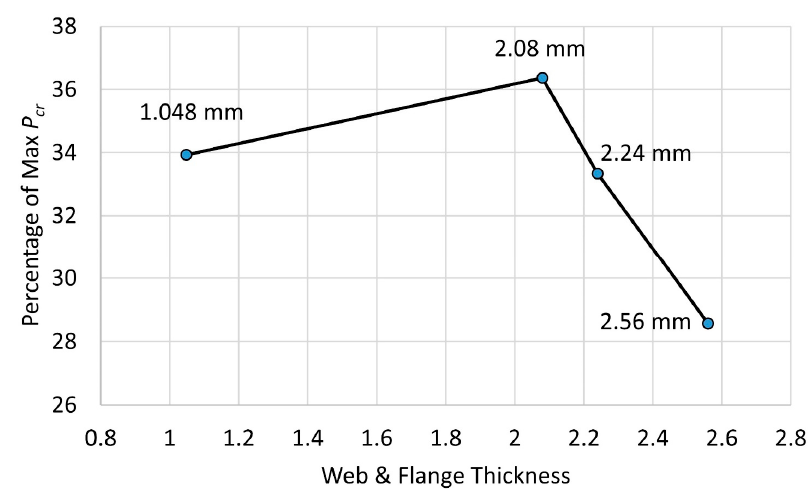
Figure 13. Cost e ffi ciency of column thickness on the critical buckling Figure 13. Cost efficiency of column thickness on the critical buckling load.